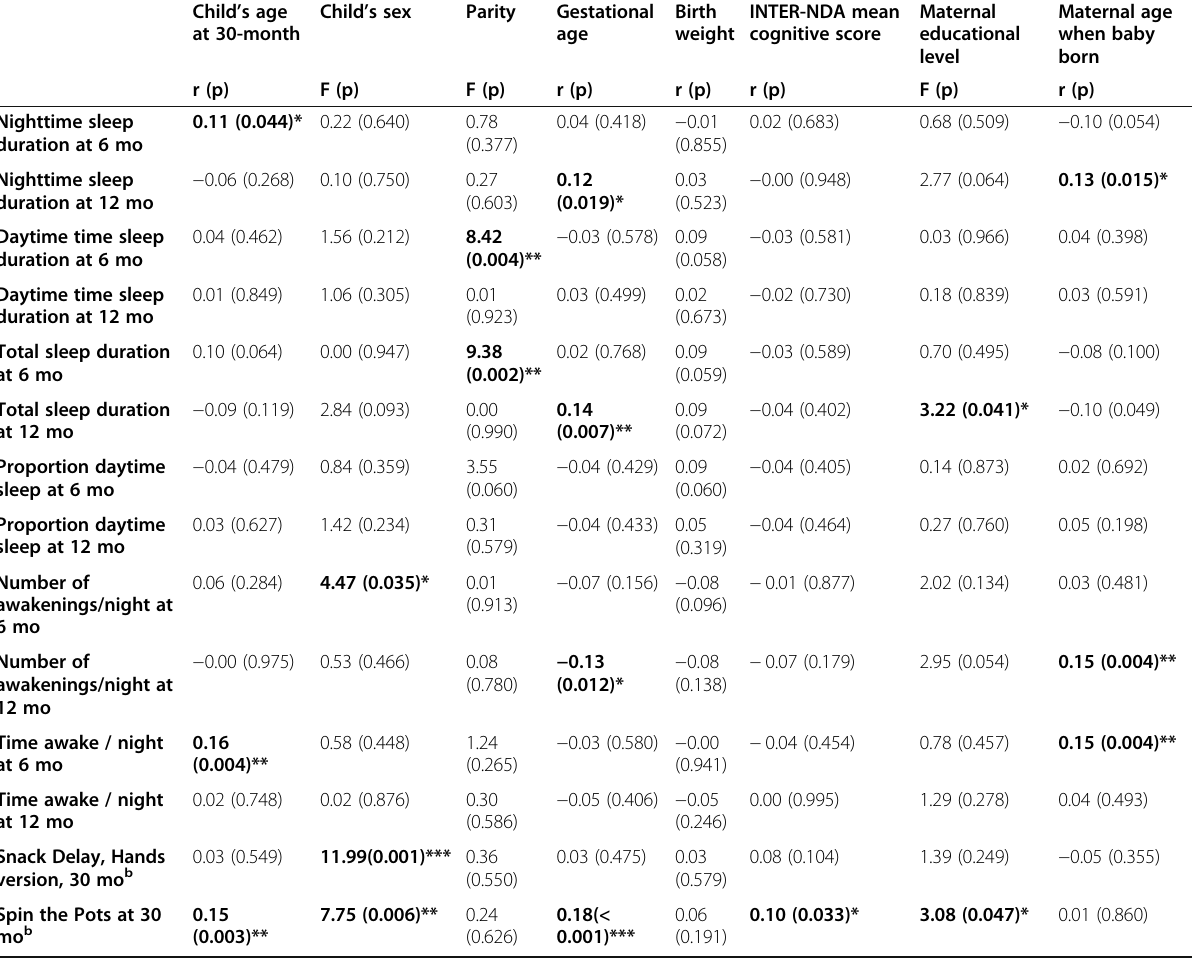
Table 3 Correlations between sociodemographic measures, and sleep at 6 and 12 months, and executive function at 30 months